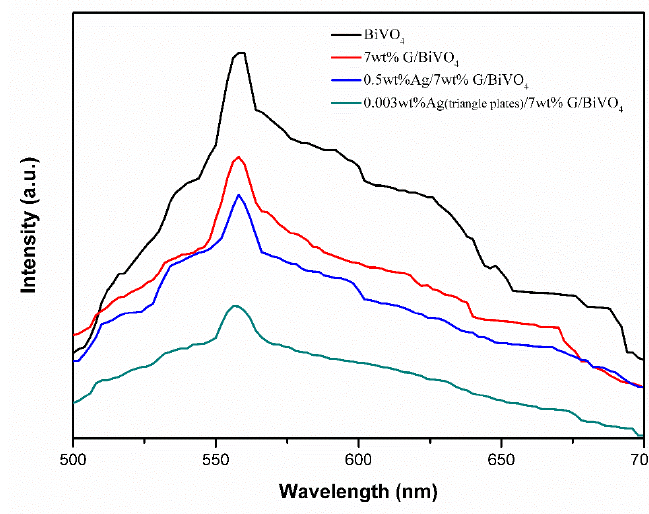
Figure 6. PL spectra of the as-obtained photocatalysts.